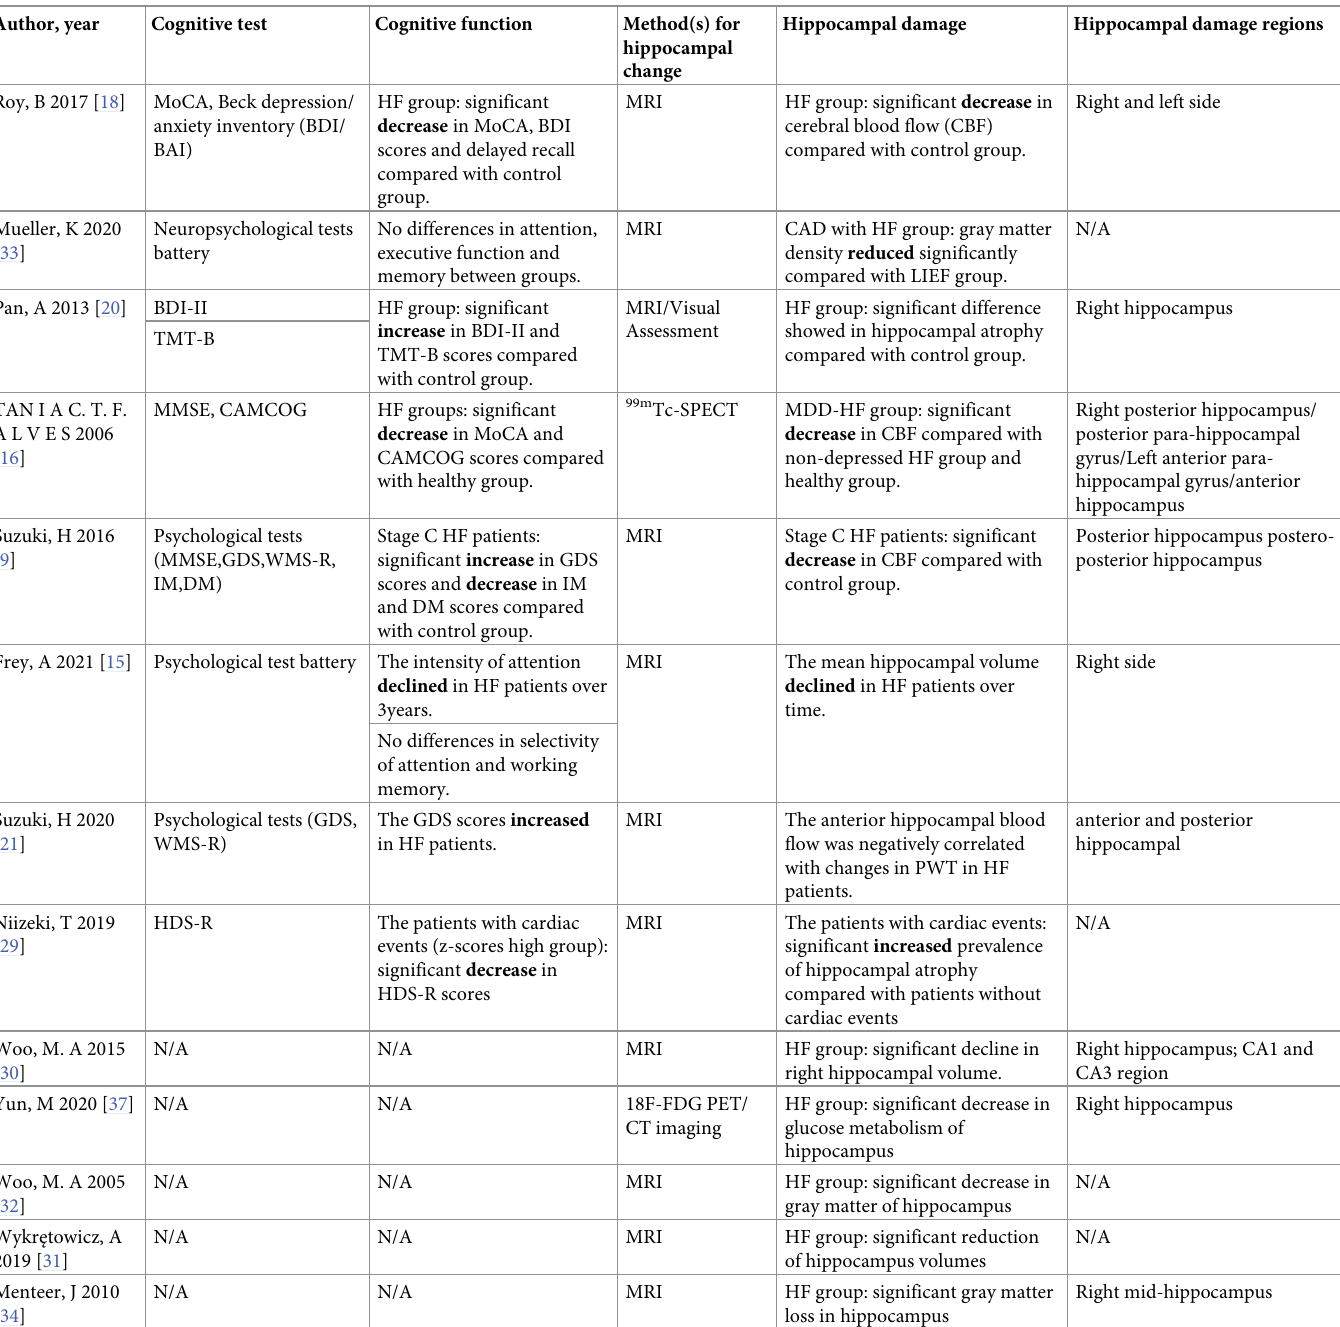
Table 6. Characteristics of cognition and hippocampal changes in clinical